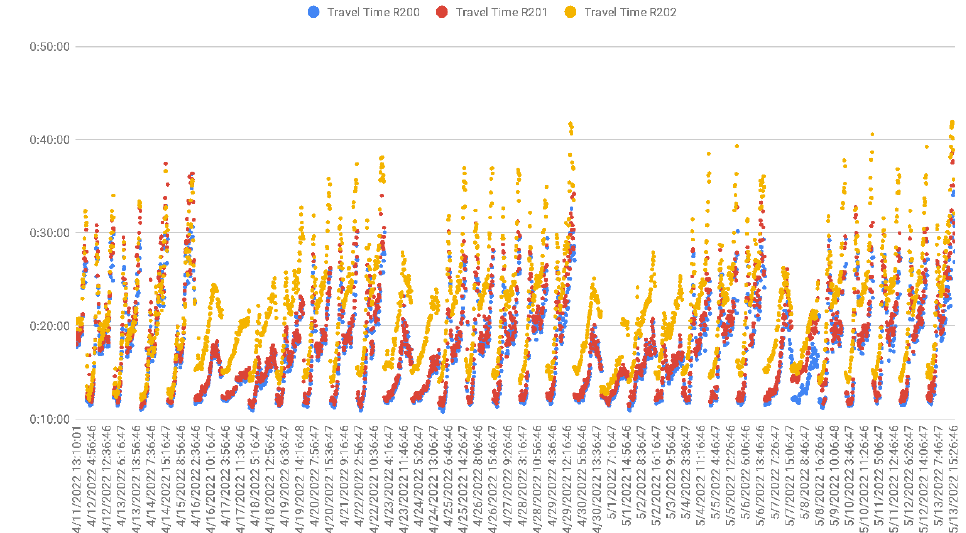
Figure 7. Google Cloud data from predicted travel times for three routes over a one-month period.